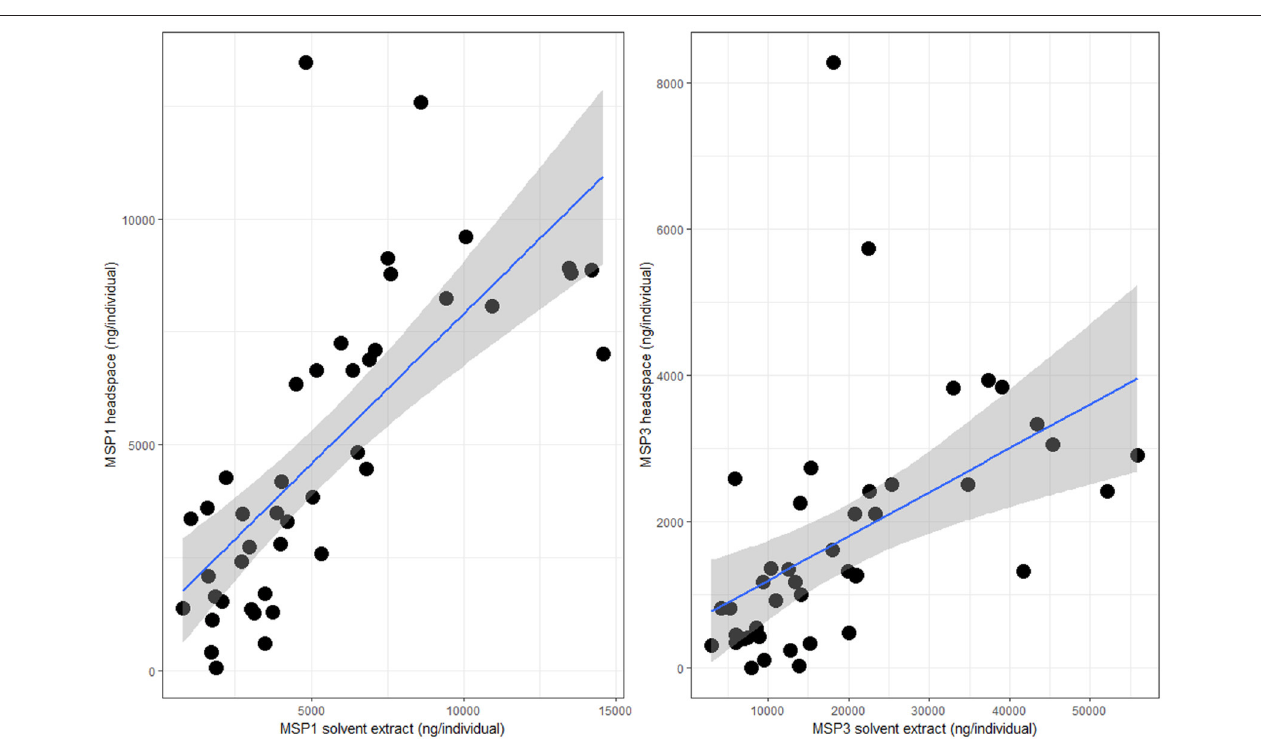
FIGURE 3 | Correlation between MSP1 (Left) and MSP3 (Right) amounts (in ng/individual) and confidence intervals obtained by headspace sampling live butterflies during 22.5h (Y axis) or wing tissue solvent extraction after completion of behavioral experiments (X axis). N = 43.